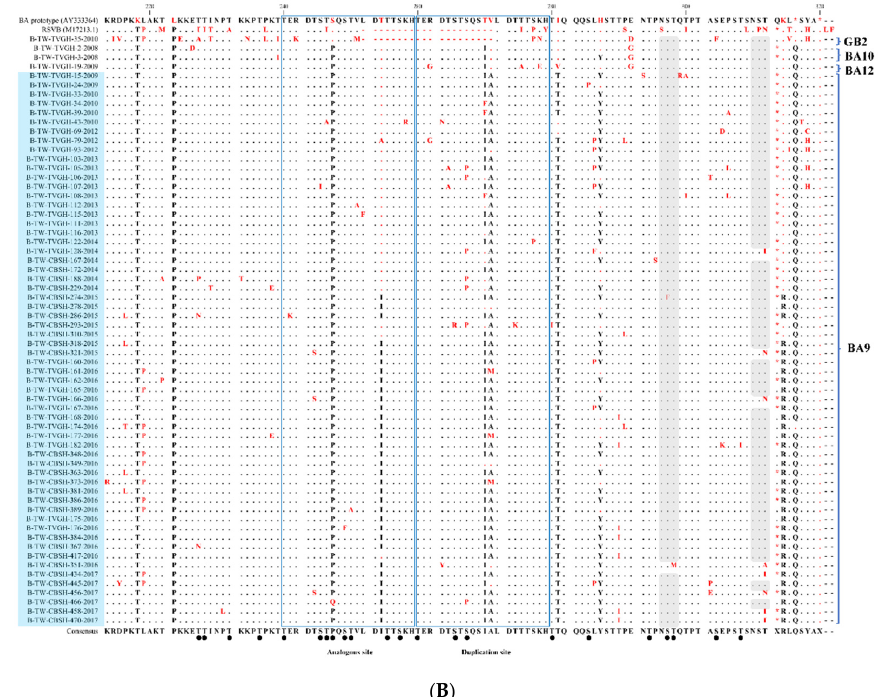
Figure 2. Alignment of the deduced amino acids of the second G protein hypervariable region of the ( A ) ON1 and ( B ) BA9 genotypes in Taiwan. All the representative sequences of the ON1 strains in this study were aligned with the ON67-1210A prototype strain (GenBank accession number: JN257963), and those of the BA9 strains were aligned with the reference strain BA4128/99B (AV333364). The substituted amino acids are indicated in red. The ON1 and BA9 sequences of this study were high- lighted by light yellow and light blue colors, respectively. The blue boxed areas indicate analogous and duplicate sites. The predicted N-glycosylation sites are highlighted in gray, and the black dots represent the predicted O-link